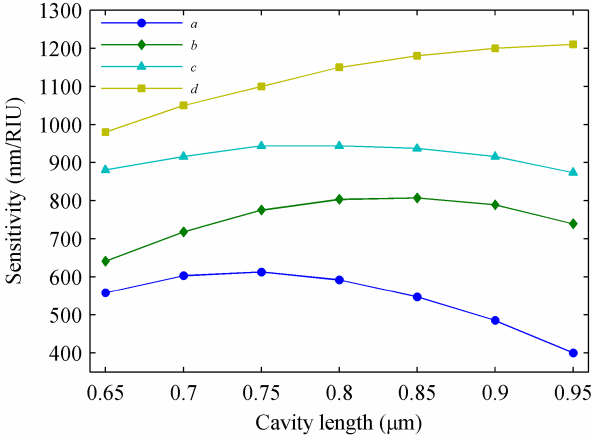
Figure 6. Sensitivity for different values of d Si and d Air as a func- tion of the cavity length. The cavities operate in different band gap regions shown in Fig. 2: a ( d Si = 0 . 52µm and d Air = 0 . 42µm), b ( d Si = 0 . 36µm and d Air = 0 . 26µm), c ( d Si = 0 . 32µm and d Air = 0 . 6µm), and d ( d Si = 0 . 14µm and d Air = 0 .